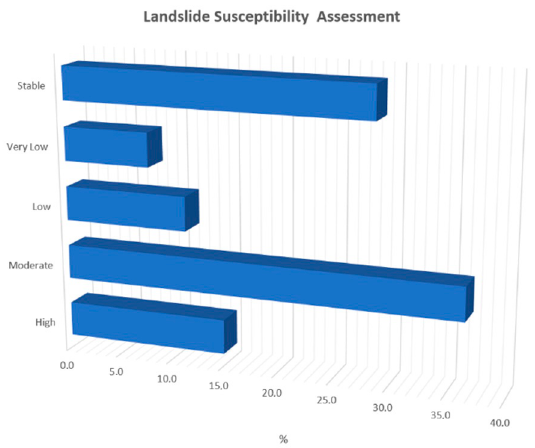
Figure 6. Map of landslide susceptibility based on the model.